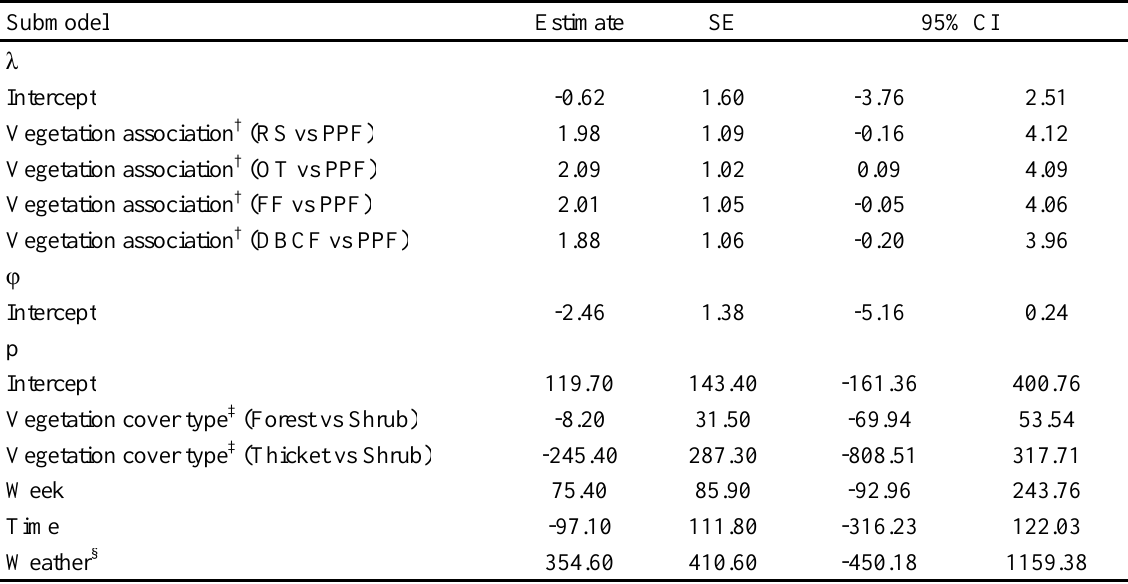
Table 4. Best model (AIC = 264.30) parameter estimates, standard errors (SE), and 95% confidence intervals (CI) used to explain Buff-throated Partridge ( Tetraophasis szechenyii ) abundance ( λ ), availability ( φ ), and detection probability (p). Estimates are on the log-scale for λ and on the logit-scale for φ and